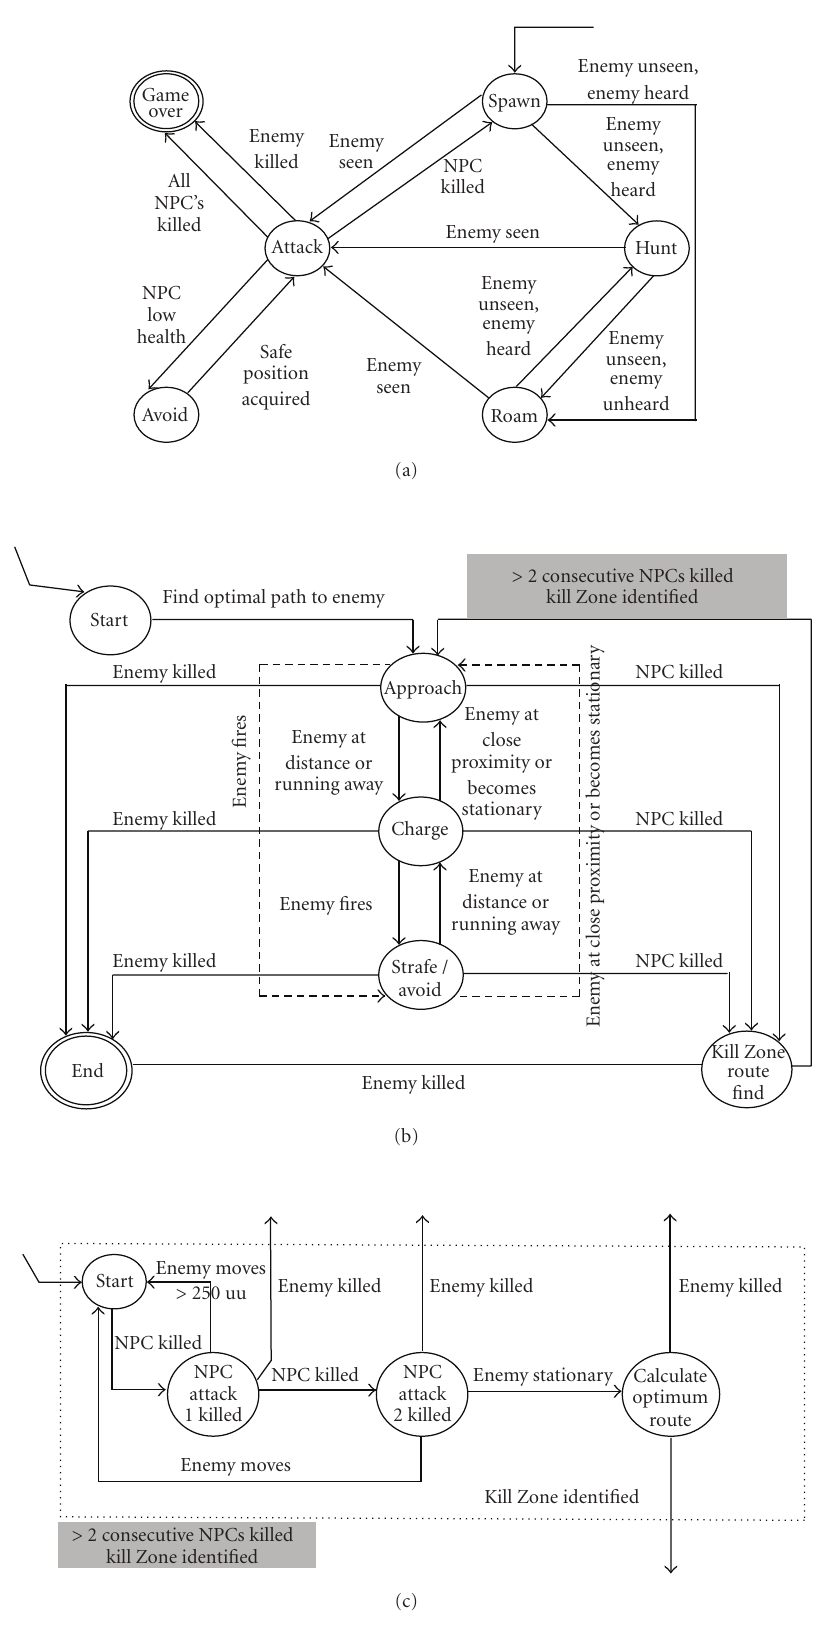
Figure 3: (a) Proposed antikill zone nonplayer character FSTN. (b) Anti-Kill zone “Attack” state detailed. (c) “Kill Zone Identified” transition